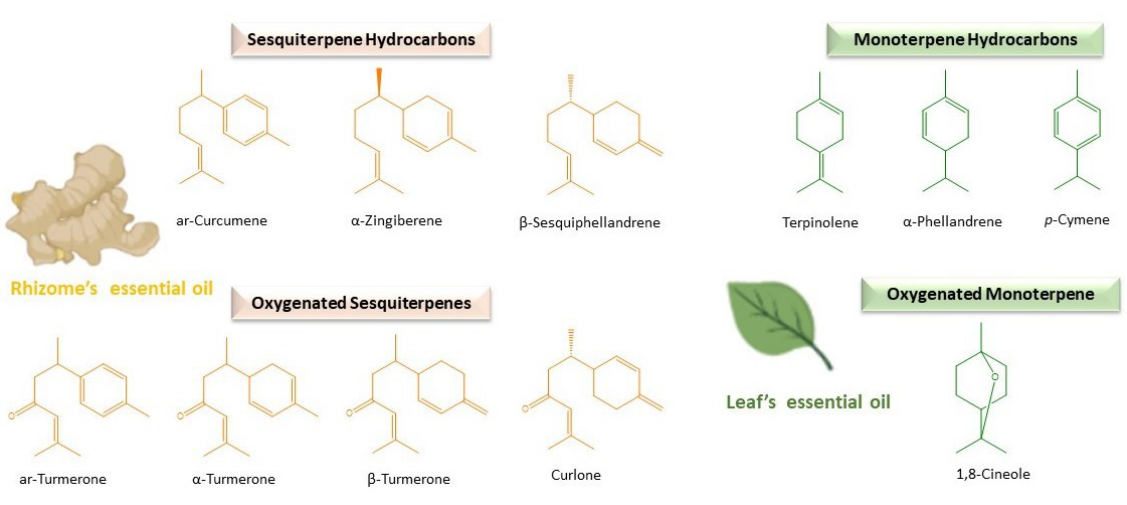
Figure 1. Main compounds found in the rhizomes and leaves of turmeric essential oils. C. longa nutrition also has a significant impact in the yield and composition of rhizome oil. Especially, fertilizer use can enhance the productivity of volatile oil of C. longa rhizomes 6% [148]. Furthermore, a prior treatment with minerals during in vitro rhizome development followed by a fertilizer treatment in a greenhouse increases the percentage of volatiles in C. longa rhizomes. Particularly remarkable is the interaction of KNO 3 and Ca 2+ , which favours the accumulation of sesquiterpenes in turmeric rhizome [168]. An interesting research proposed the use of arbuscular mycorrhizal fungi instead of chemical fertilizers in the cultivation of C. longa rhizomes. These optimise the absorption of nutrients and water, augment the metabolic activity of the plant, etc. In consequence, the root system becomes more robust, and the chemical composition of the essential oil is improved, increasing the production of certain compounds, including caryophyllene, α- curcumene, β-bisabolene and β-curcumene, using sustainable technologies [169,170]. Finally, the postharvest management of turmeric rhizomes also has a noteworthy influence on the quality of the derived products. Concretely, the boiling conditions, way of slicing, type of mill and speed of crushing and presence of heat and oxygen need to be controlled and standardised to obtain essential oils with certain characteristics [156]. In conclusion, the study of the chemical composition of the essential oil from the rhizome of C. longa gives us an idea of the characteristics and possible properties that it possesses. Sesquiterpenes are usually the main compounds in C. longa rhizome essential oil, highlighting the oxygenated turmerones followed by sesquiterpene hydrocarbons (Figure 1). However, the qualitative and quantitative chemical compositions of the essential oil can vary depending on the genetic and commented on factors. The knowledge of these can help to achieve a high-yield product with useful composition and properties for the agri-food industry.